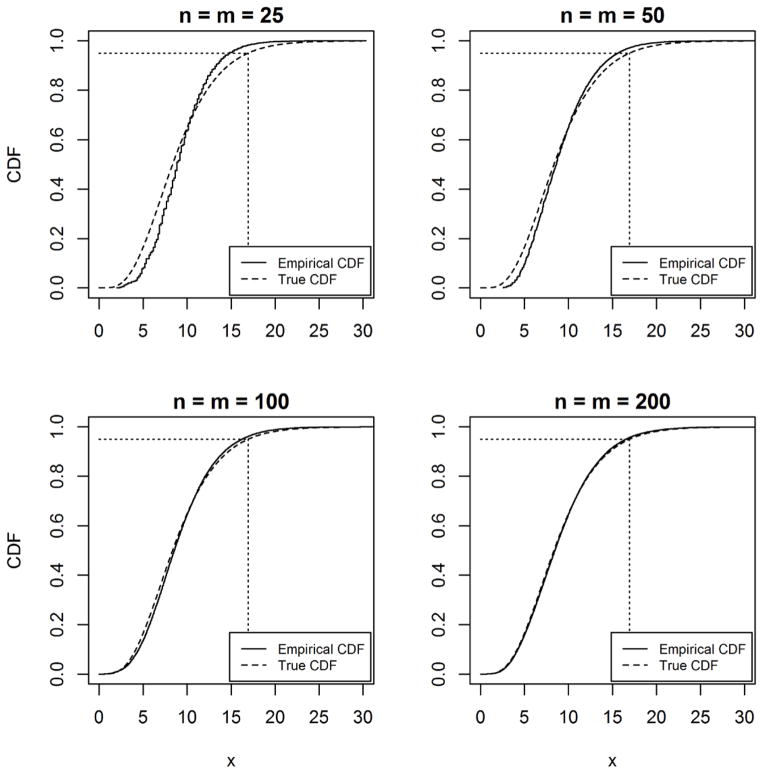
True chi-squared Cumulative Distribution Function (CDF) compared to empirical CDF of test statistic from 100,000 replicate samples under H0: Q1 = Q2 where Q = (0.01, 0.05, 0.1, 0.25, 0.5, 0.75, 0.9, 0.95, 0.99) based on simulated samples from the Gamma (shape = 2, scale = 3) distribution.